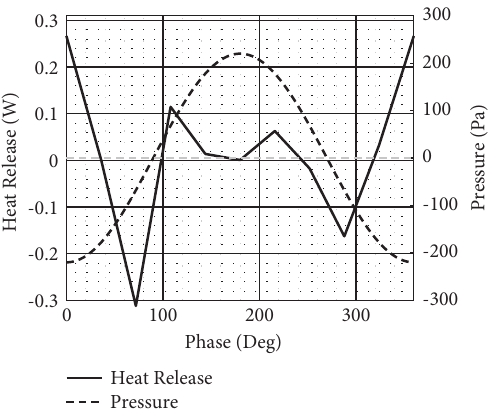
Figure 23: PIM heat release summation (W) fluctuation compared to acoustic pressure (Pa) fluctuation over instability